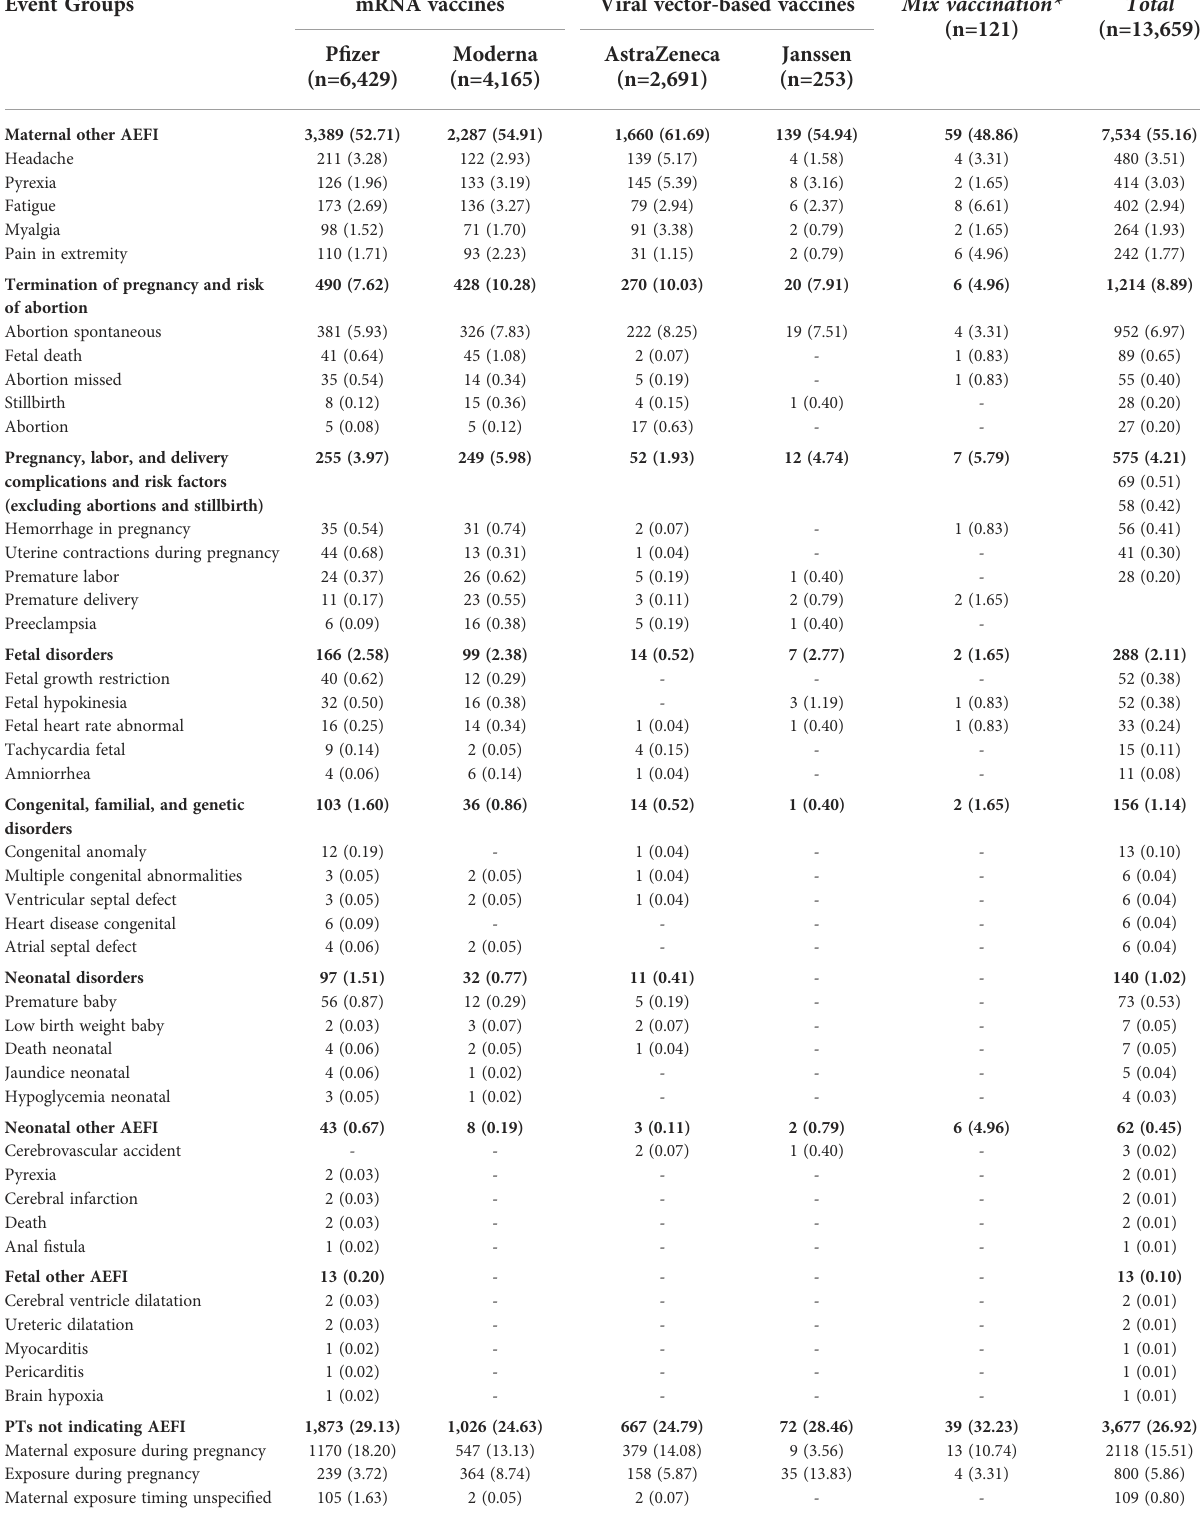
TABLE 2 AEFI related to maternal exposure during pregnancy to COVID-19 vaccines distributed by Event Groups and Preferred Terms Event